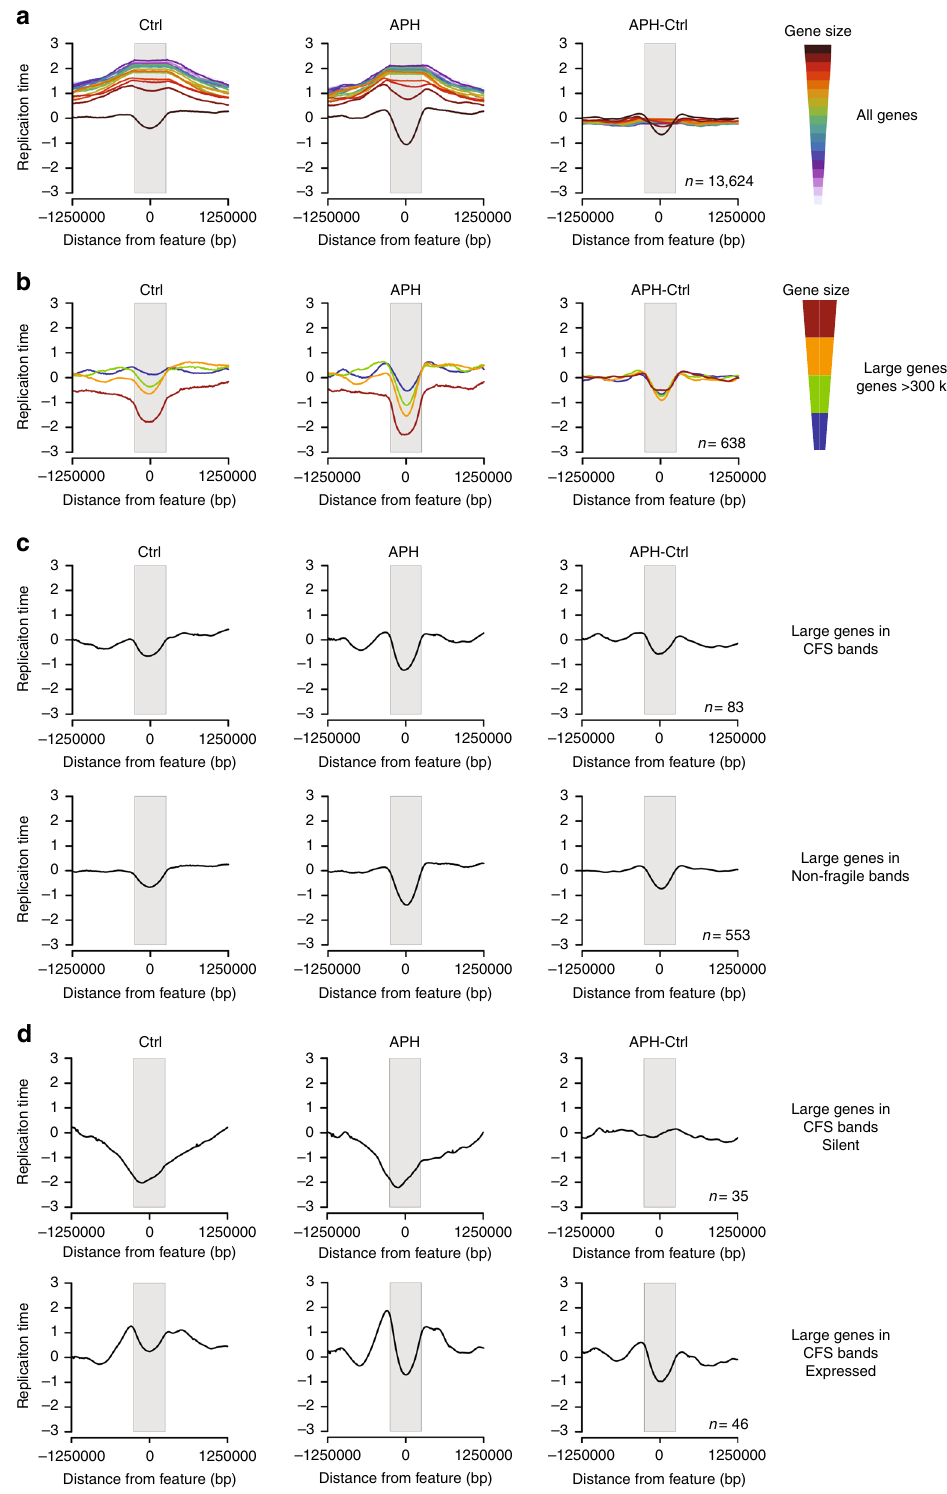
Fig. 3 APH delays the RT of expressed large genes. a Averaged RT of all genes clustered by size in Ctrl and APH-treated cells. The difference in RT following APH treatment is presented as the subtraction of the RT in Ctrl from the RT in APH-treated cells (APH-Ctrl). Genes are centered at 0 and stretched to fi t the gray box, and 1 Mb upstream and downstream the genes are presented. Genes are sorted according to size from top to bottom (largest to smallest, respectively) and color coded by cluster as indicated. b Averaged RT of large genes (>300 kb) are represented as in ( a ). Genes are sorted according to size from top to bottom (largest to smallest, respectively) and color coded by cluster as indicated in Ctrl, APH, and APH-Ctrl. c Averaged RT of large genes within CFS bands (at the top) and in non-fragile cytogenetic bands (at the bottom) in Ctrl, APH, and APH-Ctrl. d Averaged RT of large genes within CFS bands. At the top are silent genes, at the bottom are expressed genes in Ctrl, APH, and